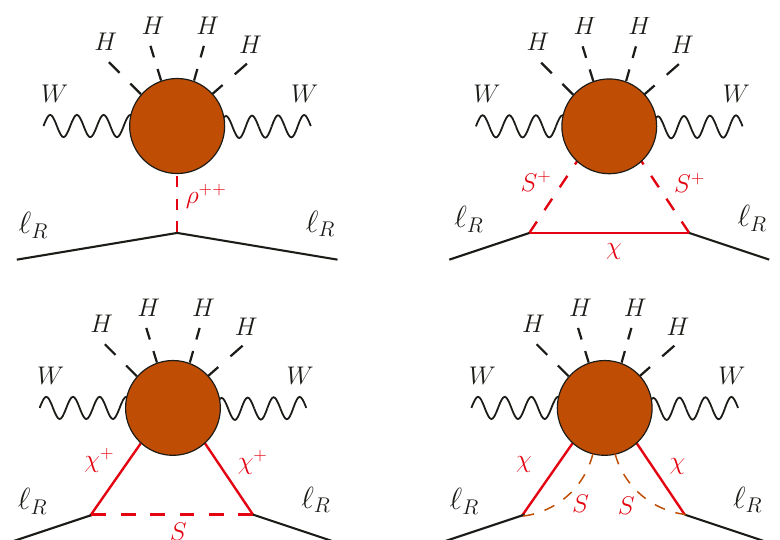
Figure 2 . Top-left: opening-up operator BSM operator (cid:31) states, respectively giving rise to the e(cid:11)ective BSM operators (2.8). BSM states are depicted in